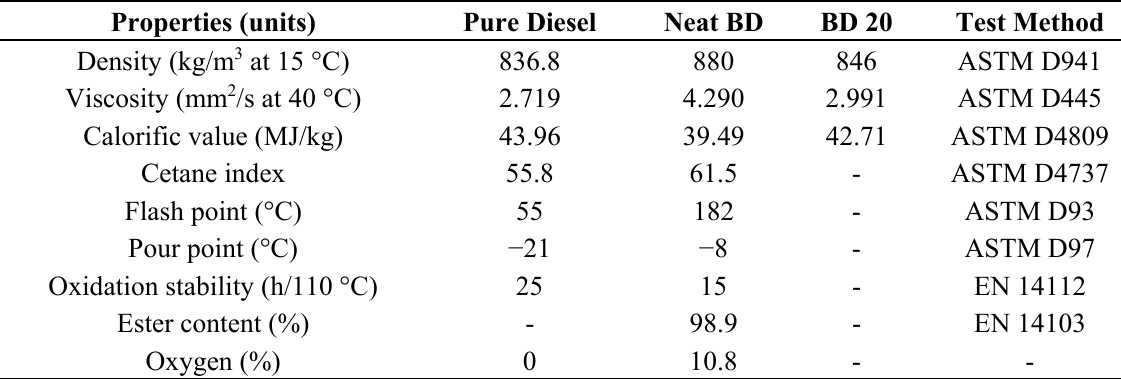
Table 1. Properties of pure diesel, neat biodiesel, and BD20 (20 vol % canola oil and 80 vol % diesel fuel